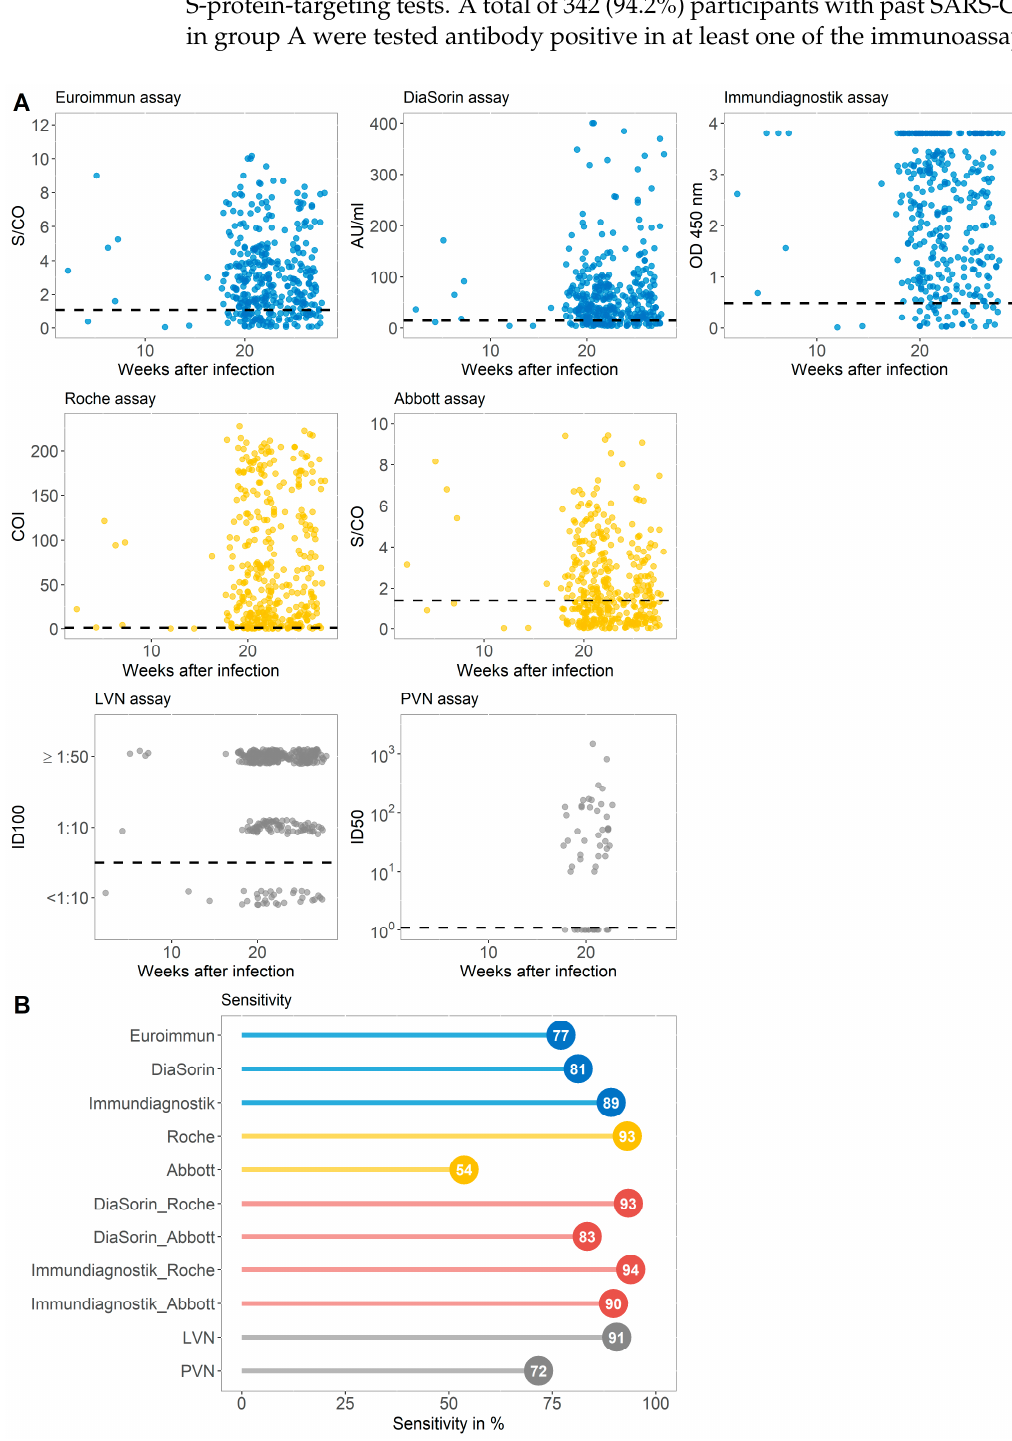
Figure 2. ( A ) Antibody values of five commercially available immunoassays targeting the S (spike) (blue) or the NC (nucleocapsid) protein (yellow) and virus neutralizing assays (grey) displayed against the weeks after infection for each individual from group A. Dashed horizontal lines display cutoff values of individual serological assays. Results of the virus neutralizing immunoassay are categorized into <1:10, 1:10, and ≥ 1:50. ( B ) The sensitivity in % achieved by assays against the S-protein (blue), the NC antigen (yellow), the combination of assays targeting the different proteins (red), and the virus neutralizing (VN) test (grey) for group A. LVN, live virus neutralization assay; PVN, pseudovirus neutralization assay; ID100, 100% inhibitory dilution; ID50, 50% inhibitory dose.